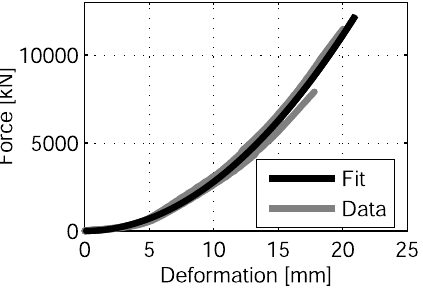
Fig. 9. Loading curves used to fi t parameters β 1 and β 2 along with least squares fi t [18].